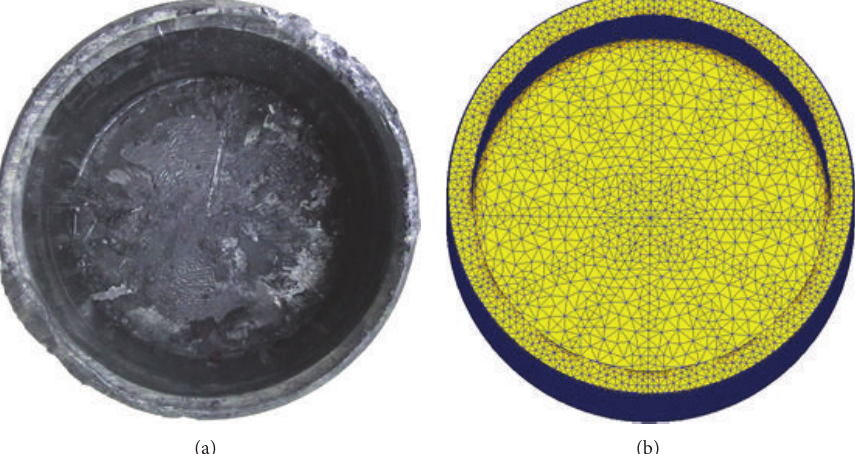
Figure 9: Cylindrical cup: (a) experimental sample; (b) predicted